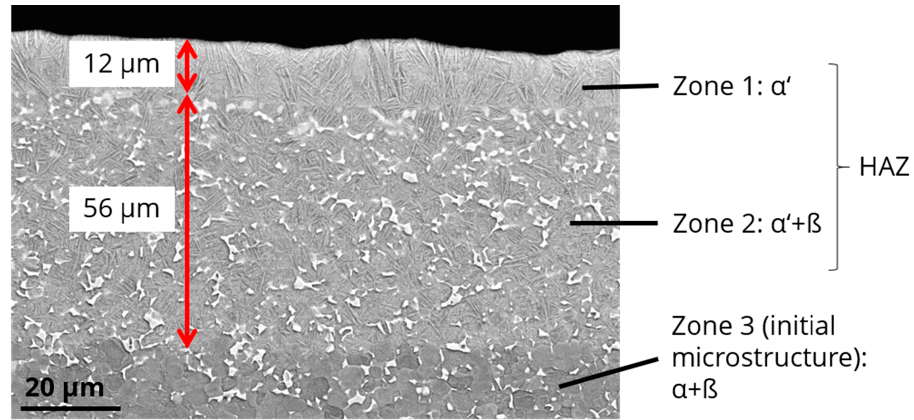
Figure 5. SEM image (BSE cross-section) of the HAZ at the lower cutting edge of a Ti-6Al_LC sample showing three distinctive microstructural zones after laser-cutting consisting of martensitic α ’-phase and retained β -phase.